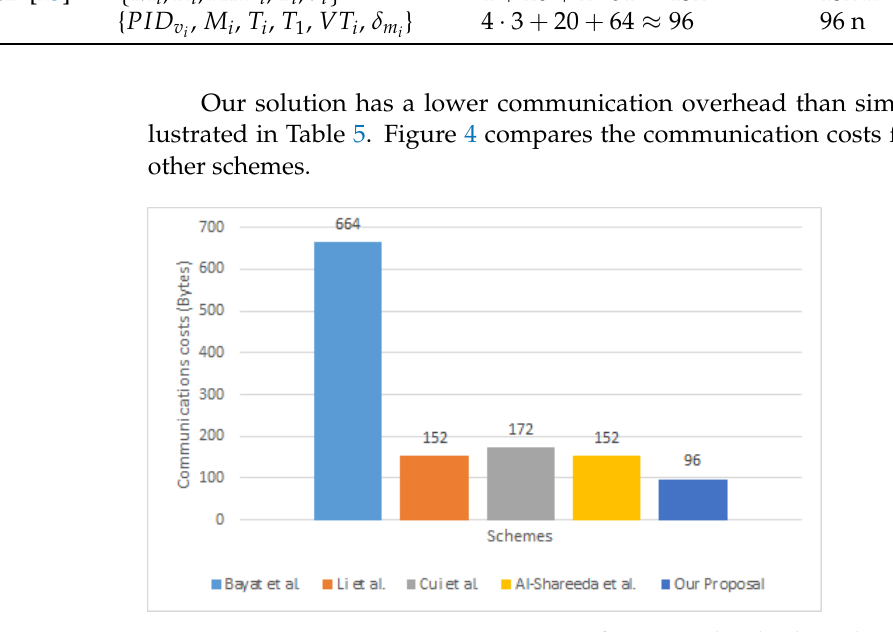
Figure 4. Comparison Communication Costs for Proposal and Other